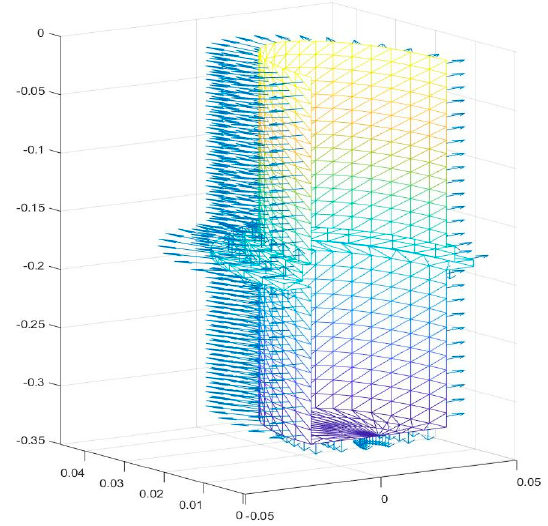
Figure 4. Computed mesh for the NEMOH model.